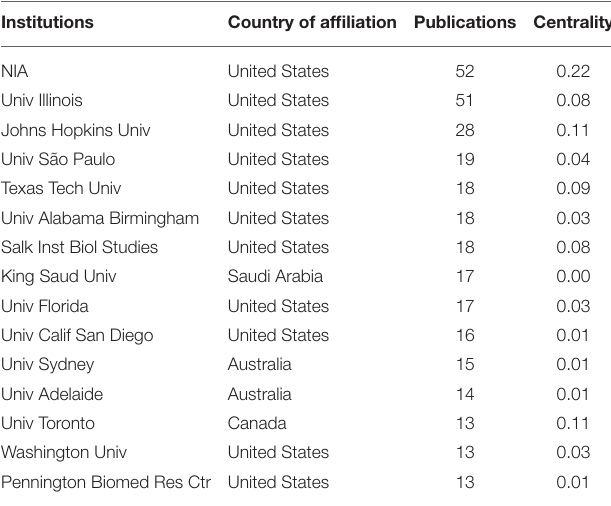
TABLE 2 | Top 15 institutions in the field of intermittent fasting research in terms of number of